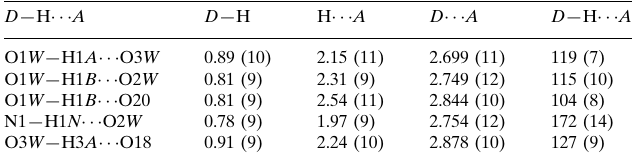
Hydrogen-bond geometry (A˚ , (cid:3)